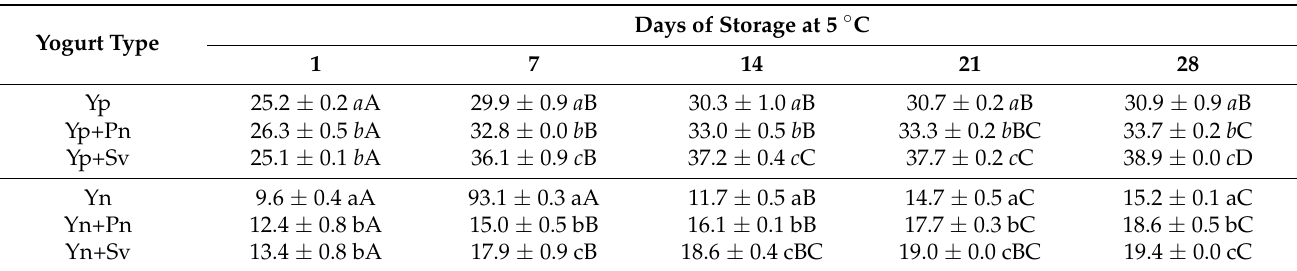
Table 7. Changes in the syneresis (%) of probiotic (Yp) and natural (Yn) yogurt with or without scCO 2 /H 2 O extracts from P. nigra (Pn) and S. viminalis (Sv) during storage *. Yogurt